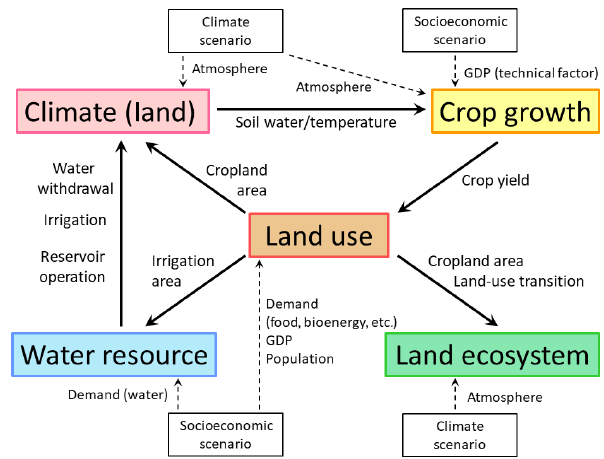
Figure 1. Relationships among variables in MIROC-INTEG- LAND. Components of the integrated model (submodels) are shown as colored boxes. Climate (land surface) and water re- source components are represented with HiGWMAT (Pokhrel et al., 2012a), which is based on the land surface model MATSIRO (Nitta et al., 2014) in a global climate model MIROC (Watanabe et al., 2010). Land ecosystem and crop growth components are repre- sented with VISIT (Ito and Inatomi 2012) and PRYSBI2 (Sakurai et al., 2014), respectively. The land-use model TeLMO (Terrestrial Land-use MOdel) is developed in this study. Inputs into the model are shown as boxes of climate and socioeconomic scenarios. Solid arrows between the boxes indicate the exchange of variables be- tween the submodels. Dashed arrows indicate the input variables of the